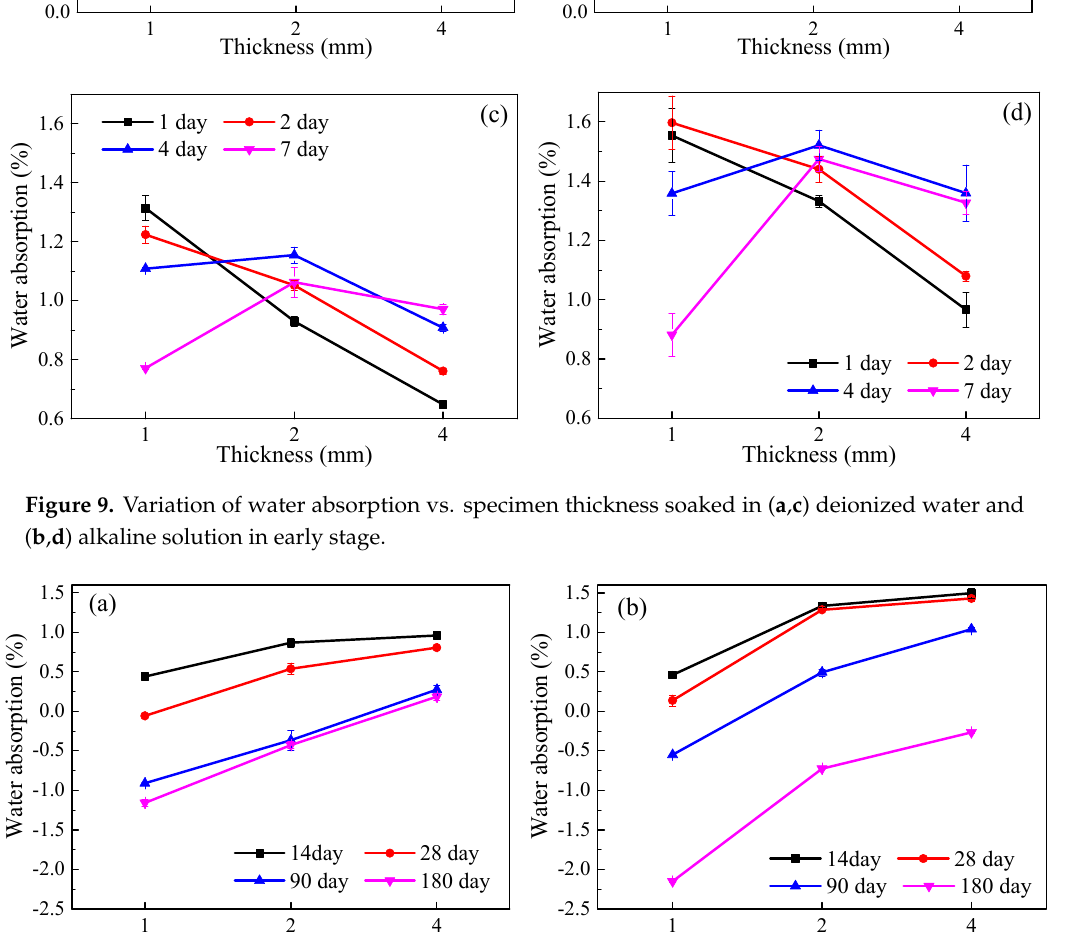
Figure 10. Variation of water absorption vs. specimen thickness soaked in ( a ) deionized water and ( b ) alkaline solution in late stage.